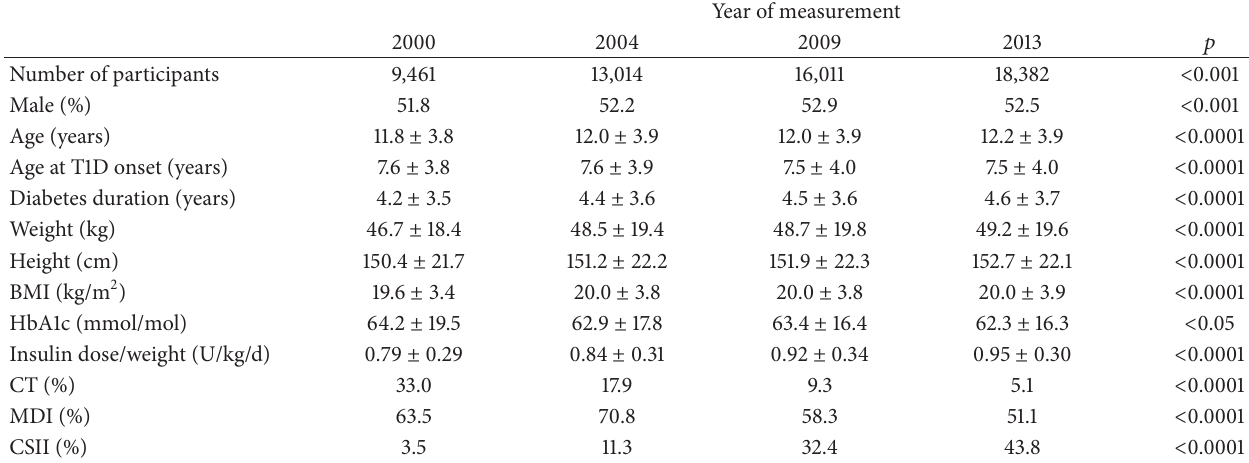
Table 1: Clinical characteristics, HbA1c level, and insulin therapy of T1D study participants. Data are given for the years 2000, 2004, 2009, and